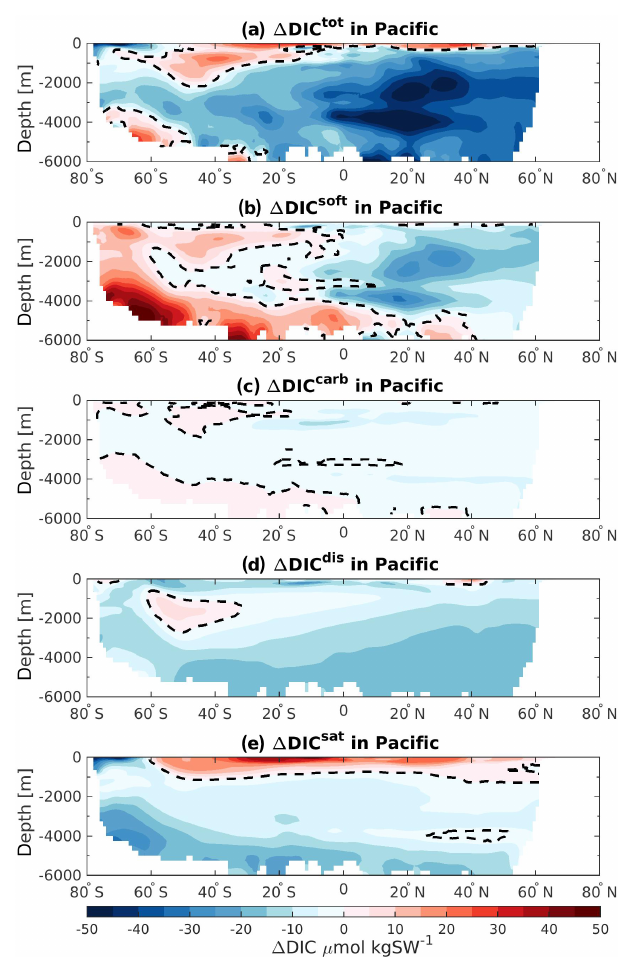
Figure 9. Same as Fig. 7 but for the Pacific